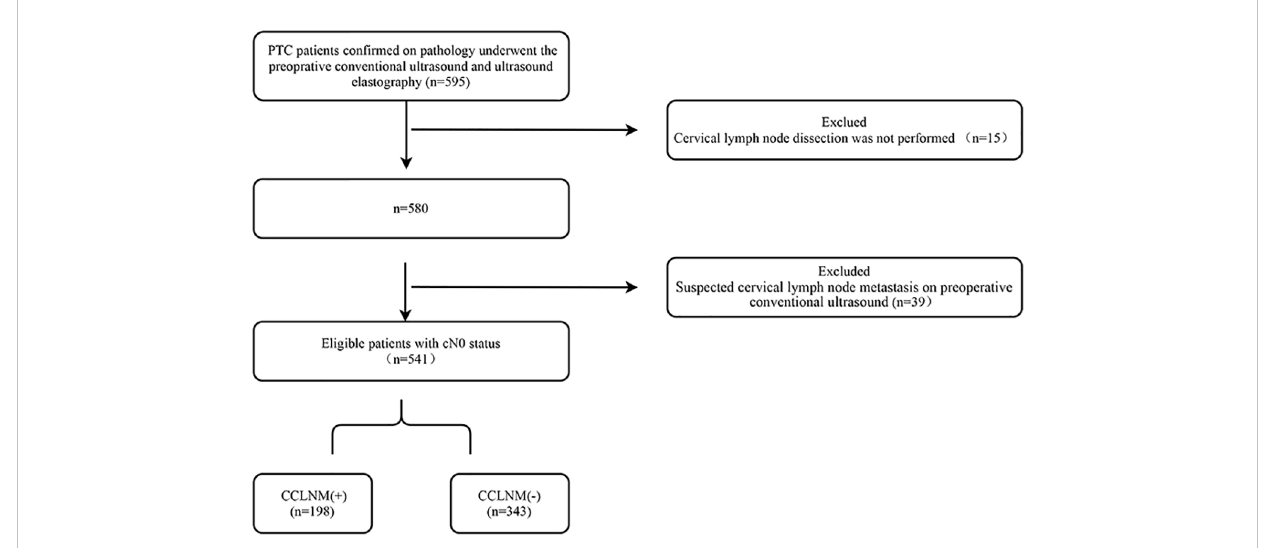
FIGURE 1 Flow chart showing patient selection process. PTC, papillary thyroid cancer; CCLNM, central cervical lymph nodes metastasis; cN0, clinically lymph